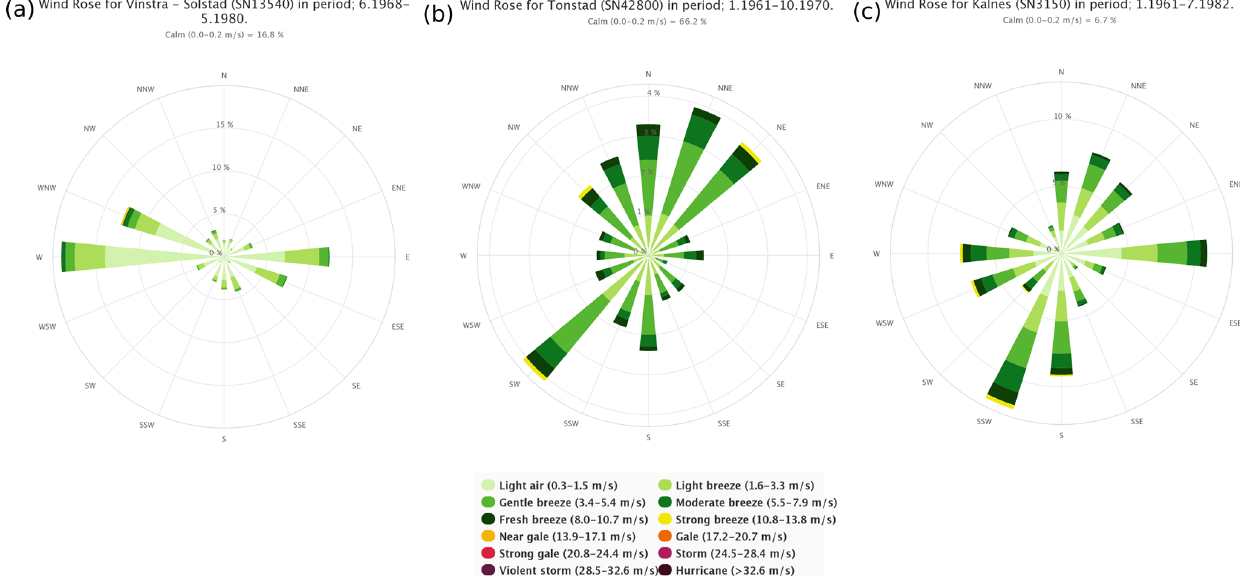
Figure A5. Annual mean 10m wind data for 1961–1990 (https://seklima.met.no/, last access: 28 November 2022) for the (a) Fron, (b) Høgs- fjorden, and (c) Sarpsborg areas. Data are taken from the nearest meteorological station with the same valley orientation as the study area.